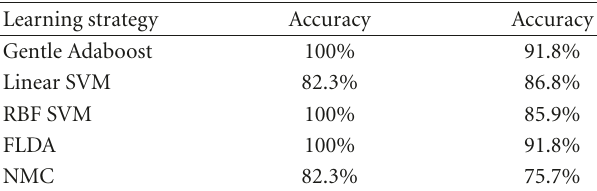
Table 4: Dominance classification results using dominance indi- cators and leave-one-out evaluation (first column) and bootstrap evaluation (second column).